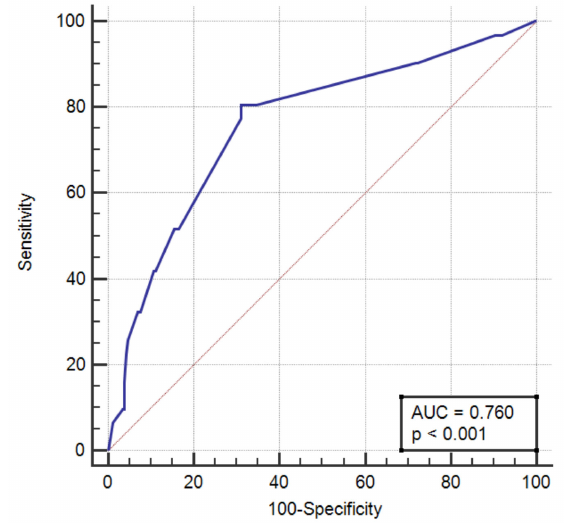
Figure 3. The ROC curve of the univariable LVEF model in patients with CHA2DS2-Vasc <